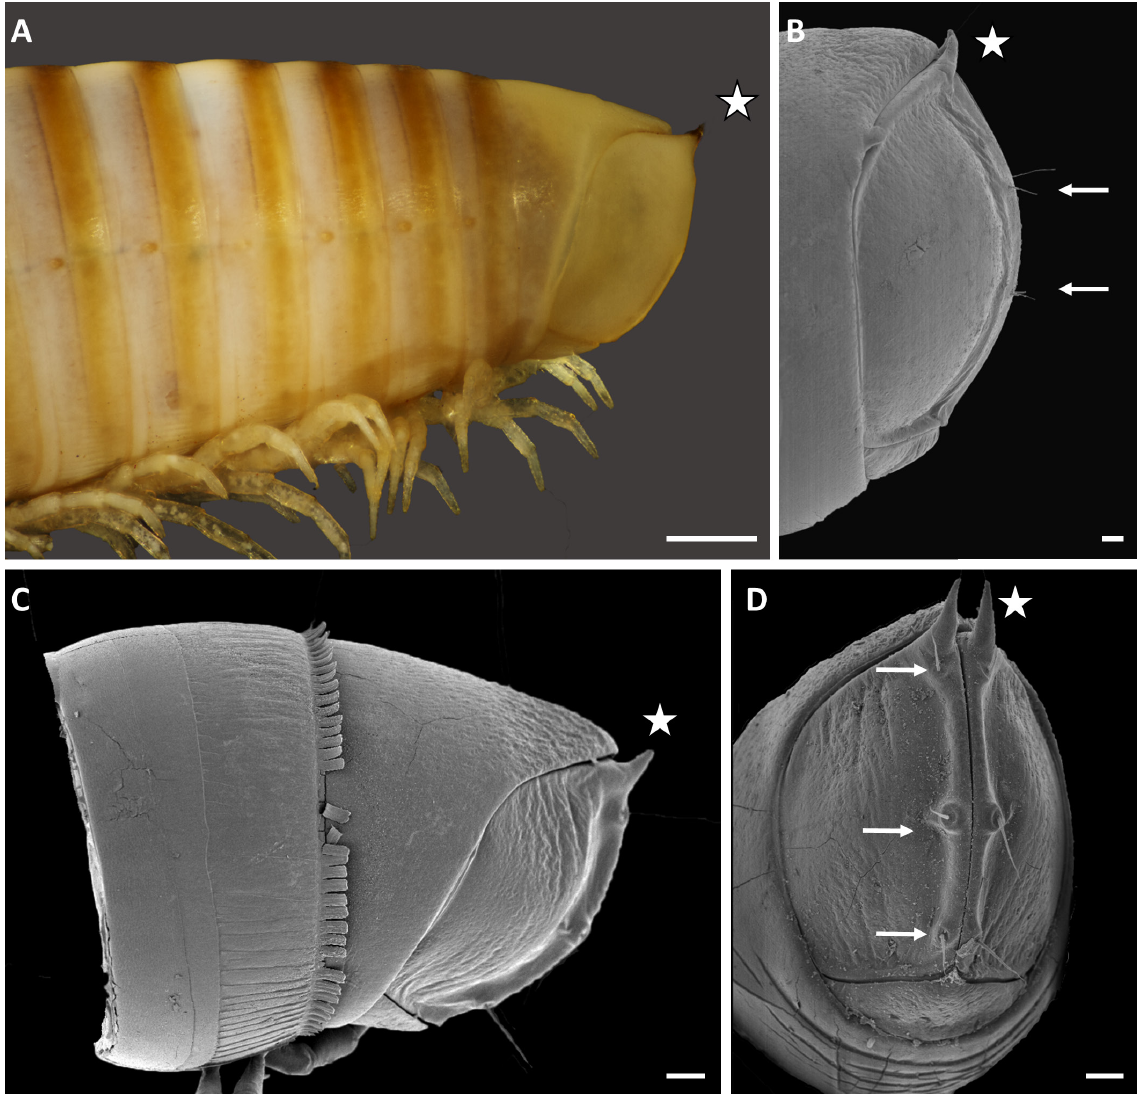
Fig. 4. Telsons of odontopygids. A . Spinotarsus axeli sp. nov., holotype, ♂ (NHMD 621761), telson and last six body rings, lateral view. B . Xystopyge bentemarieae sp. nov., paratype, ♂ (NHMD 621767), C–D . Aquattuor udzungwensis Enghoff, 2015, telson and last body ring (from Enghoff & Frederiksen